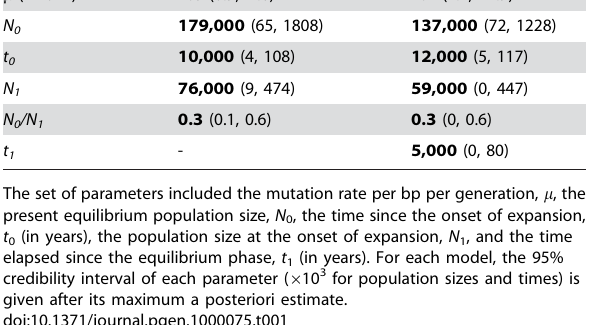
Figure 4. Onset and duration of the demographic expansion. Plot of the joint posterior distribution for the time of onset of the expansion, t 0 , and the length of the expansion, t 0 2 t 1 . Computations were performed under demographic Model C, in which the population was initially constant, then grew exponentially until t 1 , and then remained constant until the present. Percentages represent the cumulative probabilities under the density curve. The straight line indicates that the duration of expansion cannot be longer than the time elapsed since the onset of expansion.